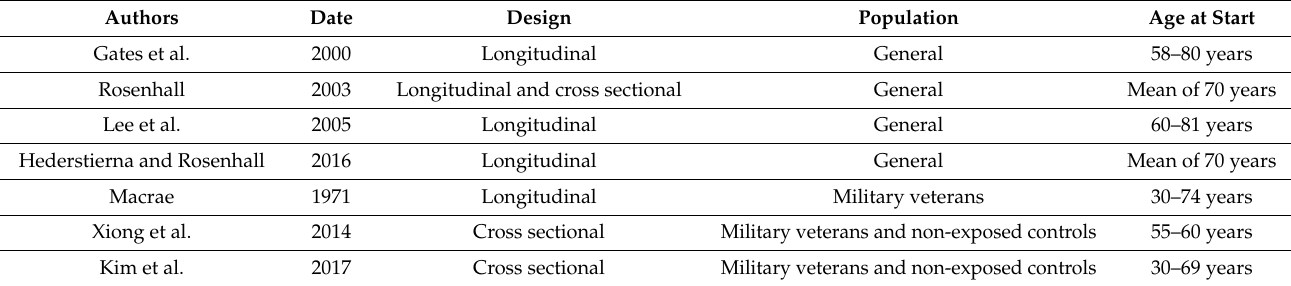
Table 1. Studies of the effect of noise exposure on the subsequent progression of hearing loss in